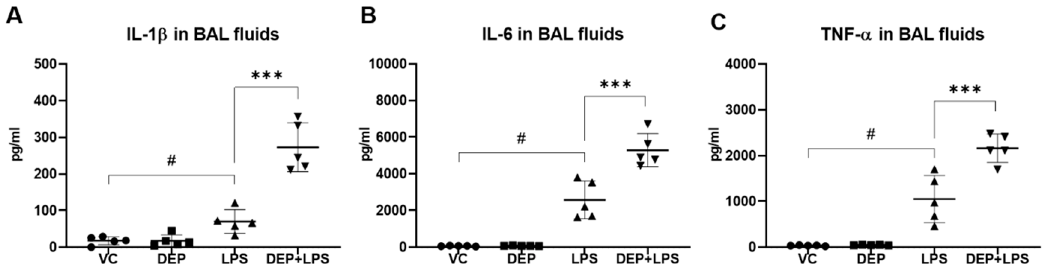
Figure 4. Protein levels of ( A ) IL-1 β , ( B ) IL-6, and ( C ) TNF- α in the bronchoalveolar (BAL) fluid from mice in the vehicle control (VC), DEP, LPS, and DEP pre-exposed and LPS-instilled (DEP+LPS) groups. Data represent means ± SD (n = 5 per group). # p < 0.05 vs. VC, *** p < 0.001 vs. LPS group.